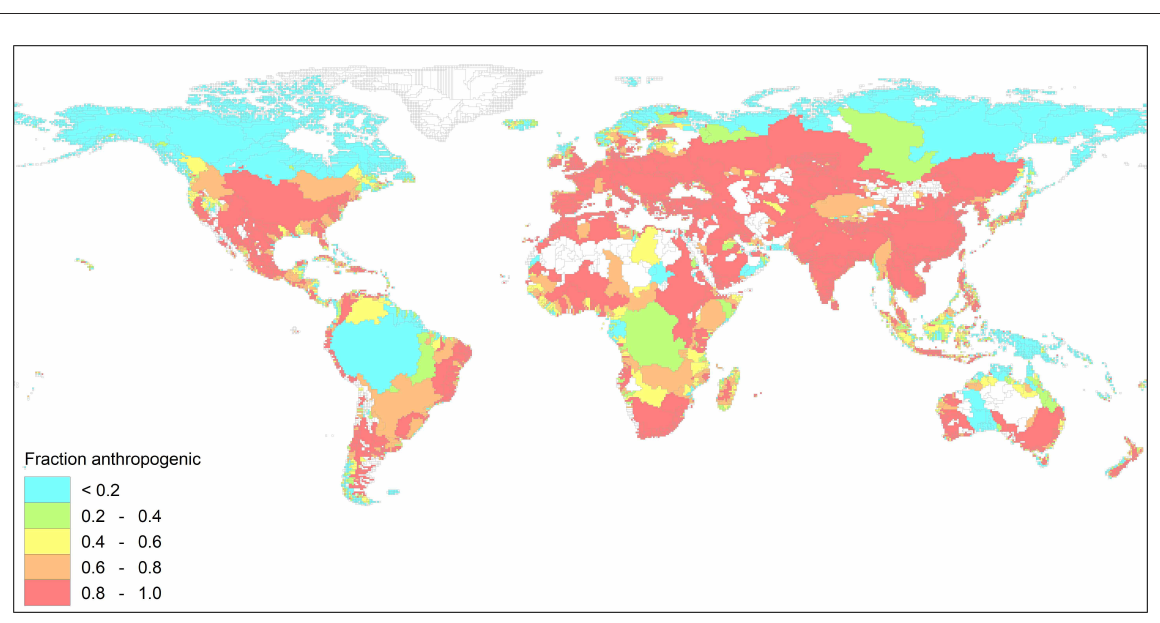
the period 1970–2015 by 24% from 17 to 21. The N:P ratios for the year 1970 and 2000 (17 and 20, respectively) exceed estimates by the Global NEWS model, which predicts a constant